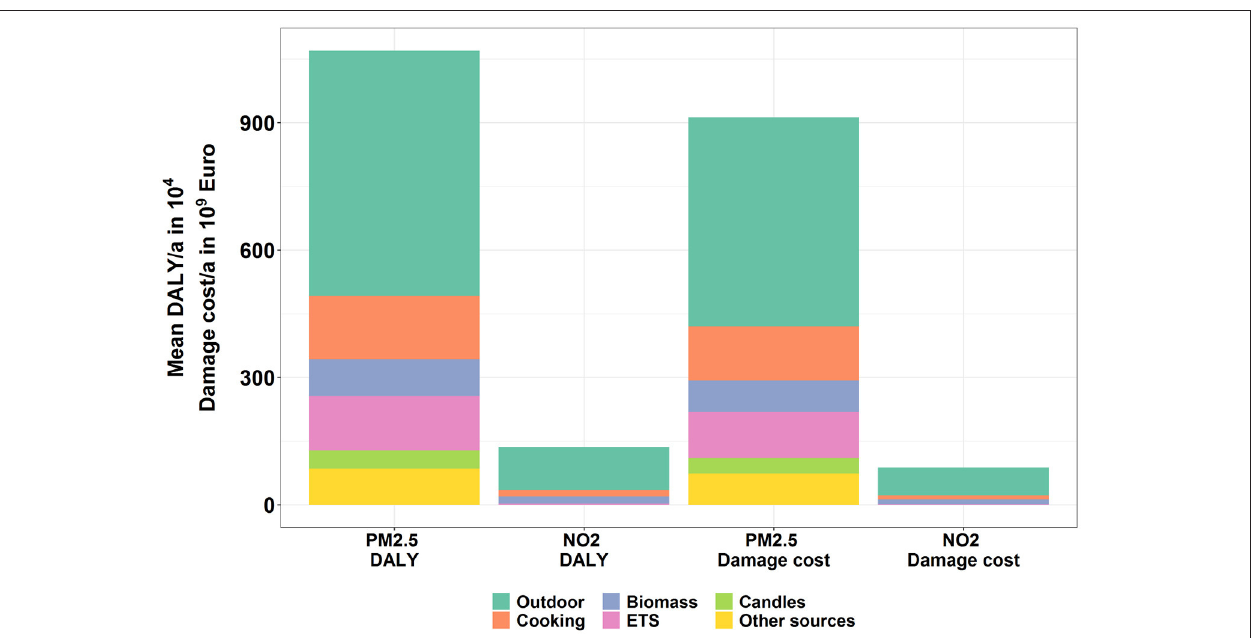
FIGURE 10 | Overall DALYs and damage costs caused by PM2.5 and NO 2 emissions of the EU countries in